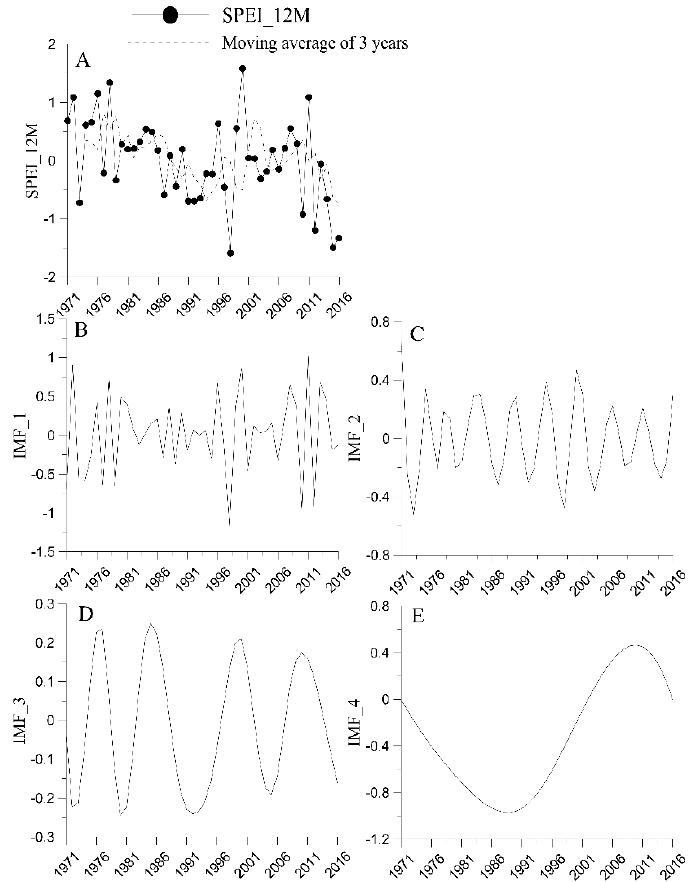
Figure 2. The variation in SPEI_12M ( A ) and the intrinsic mode functions (IMFs) obtained from the SPEI_12M value ( B – E ) over the Mun River Basin from 1971 to